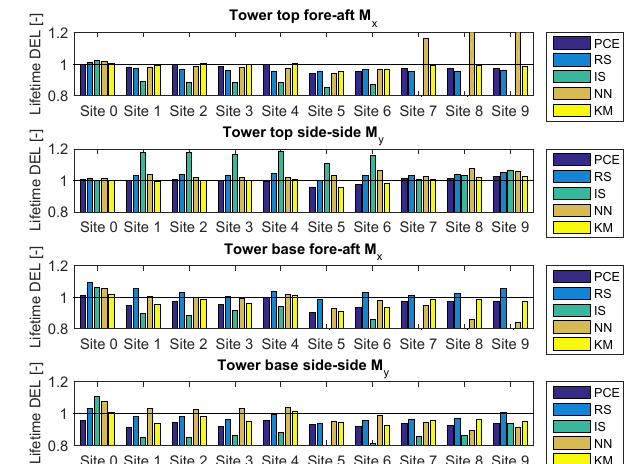
Figure 11. Predictions of lifetime damage-equivalent loads (yaw, shaft torsion, blade-root) for five different estimation approaches and four load channels. All values are normalized with respect to the mean estimate from a site-specific Monte Carlo (MC) simulation. The abbreviations refer to PCE: polynomial chaos expansion; RS: quadratic response surface; IS: importance sampling; NN: nearest- neighbor interpolation; and KM: universal Kriging